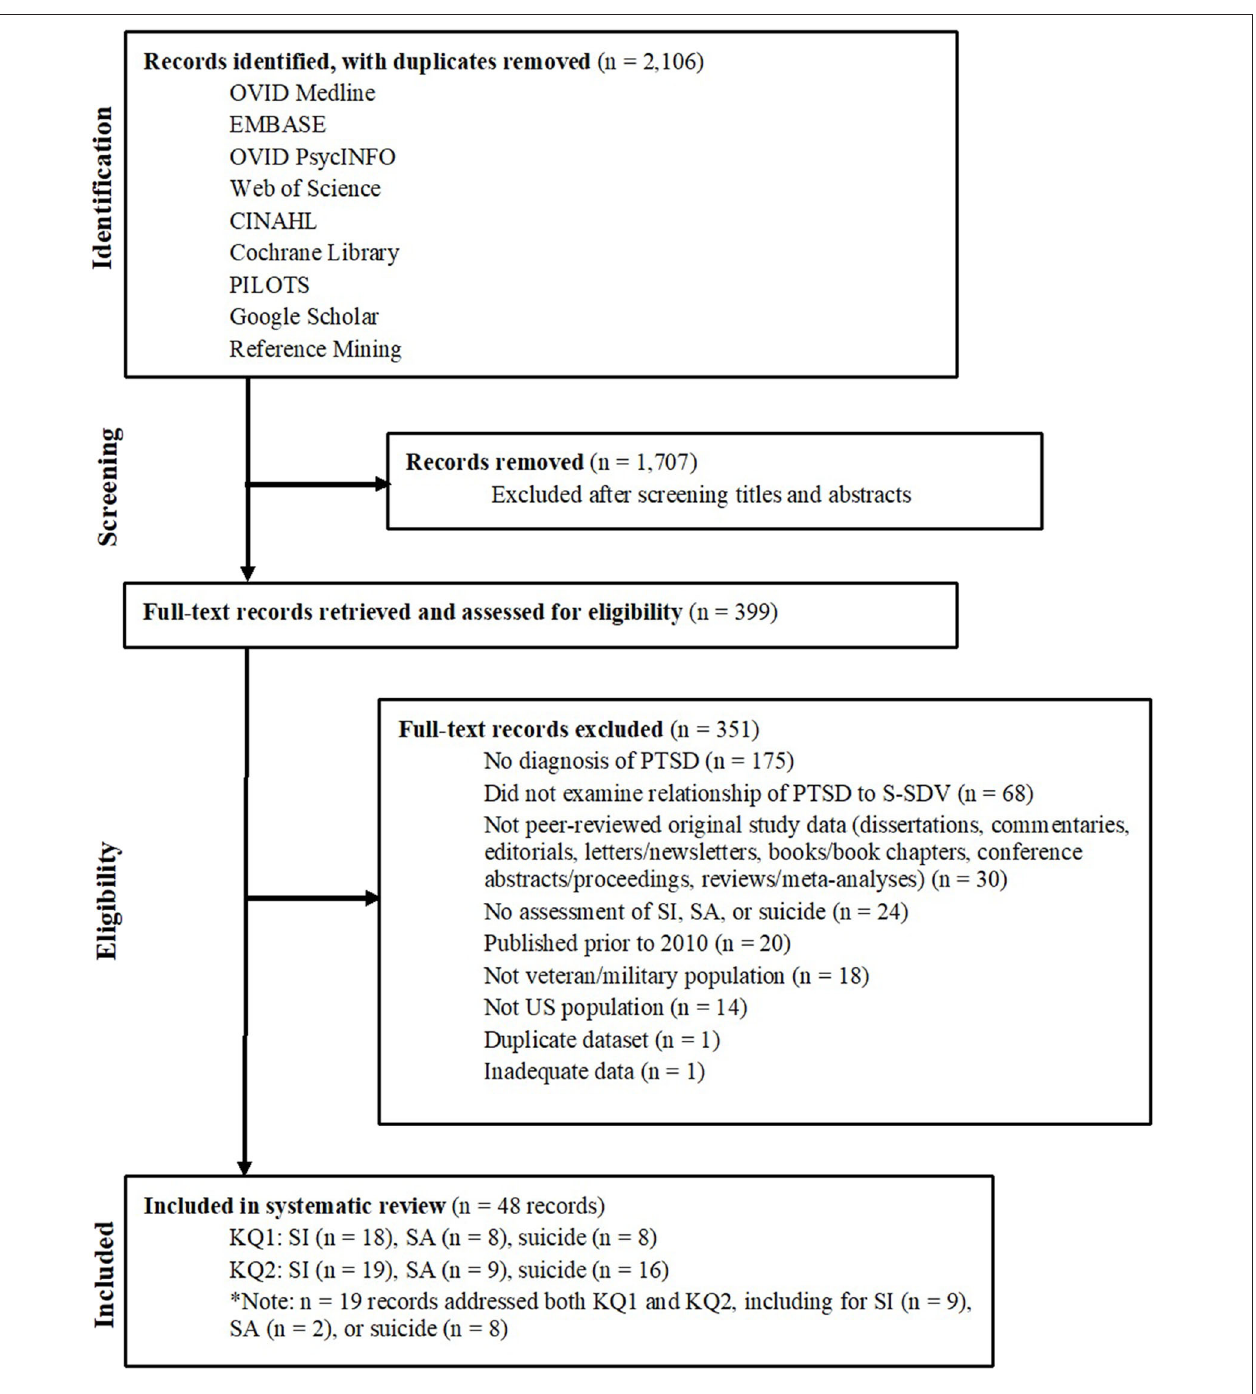
FIGURE 1 | PRISMA literature flow